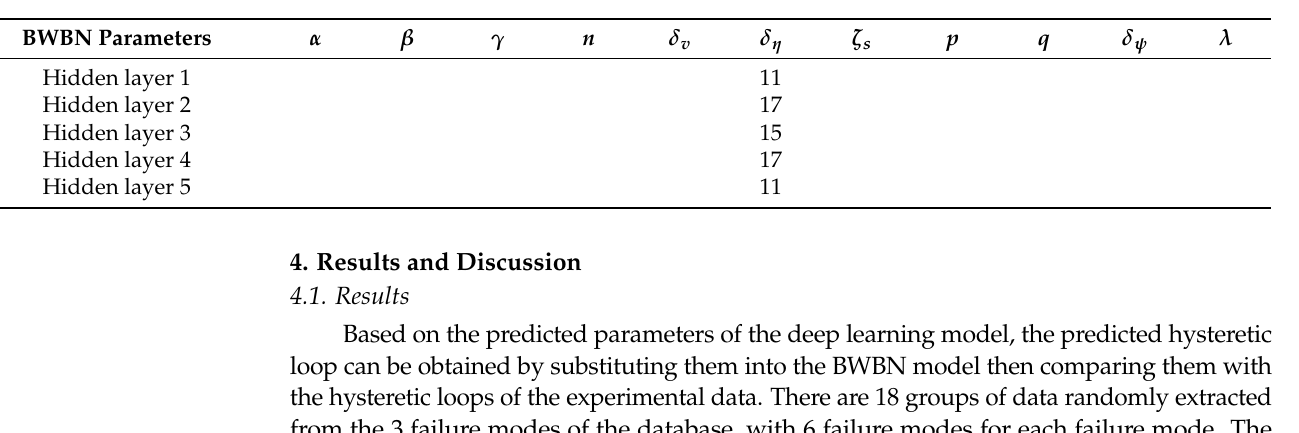
Table 1. The number of neurons of deep learning model.